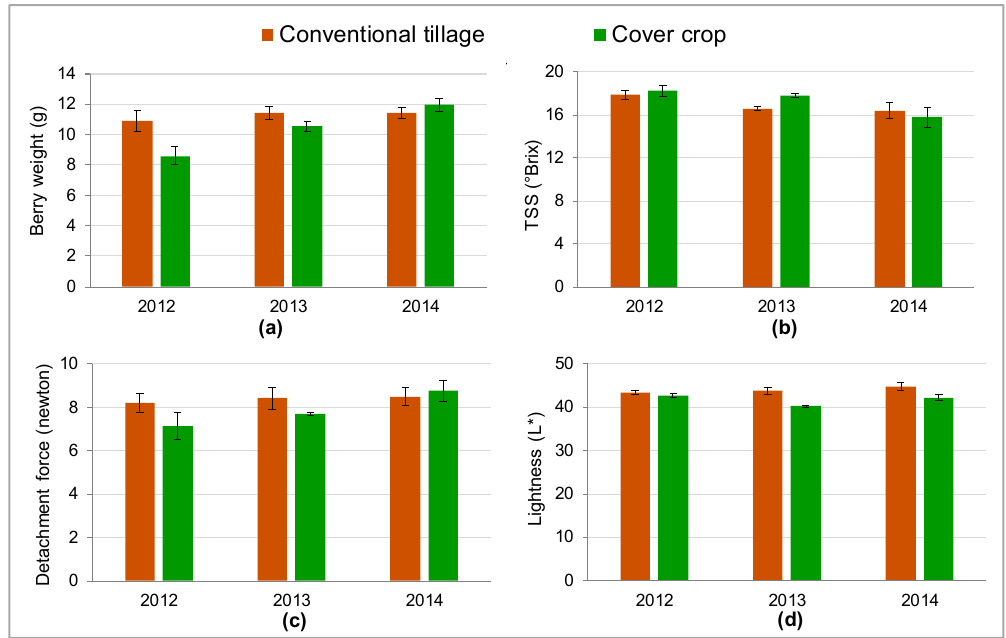
Figure 7. The trend of mean berry weight ( a ), total soluble solids ( b ), detachment force ( c ) and lightness ( d ) of grapes obtained under conventional tillage or cover crop during three years of experimentation. The bar on each column indicates the standard deviation (n = 3).